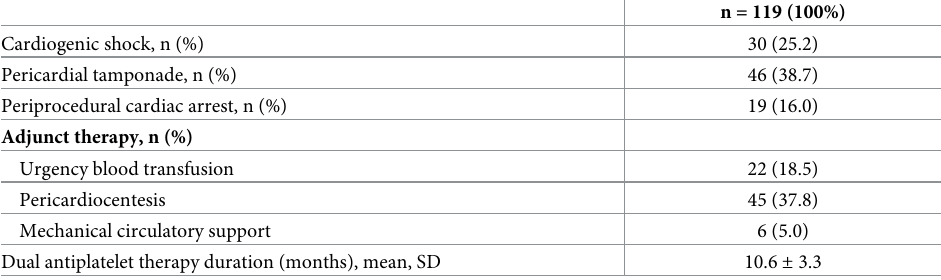
Table 3. Peri-procedural